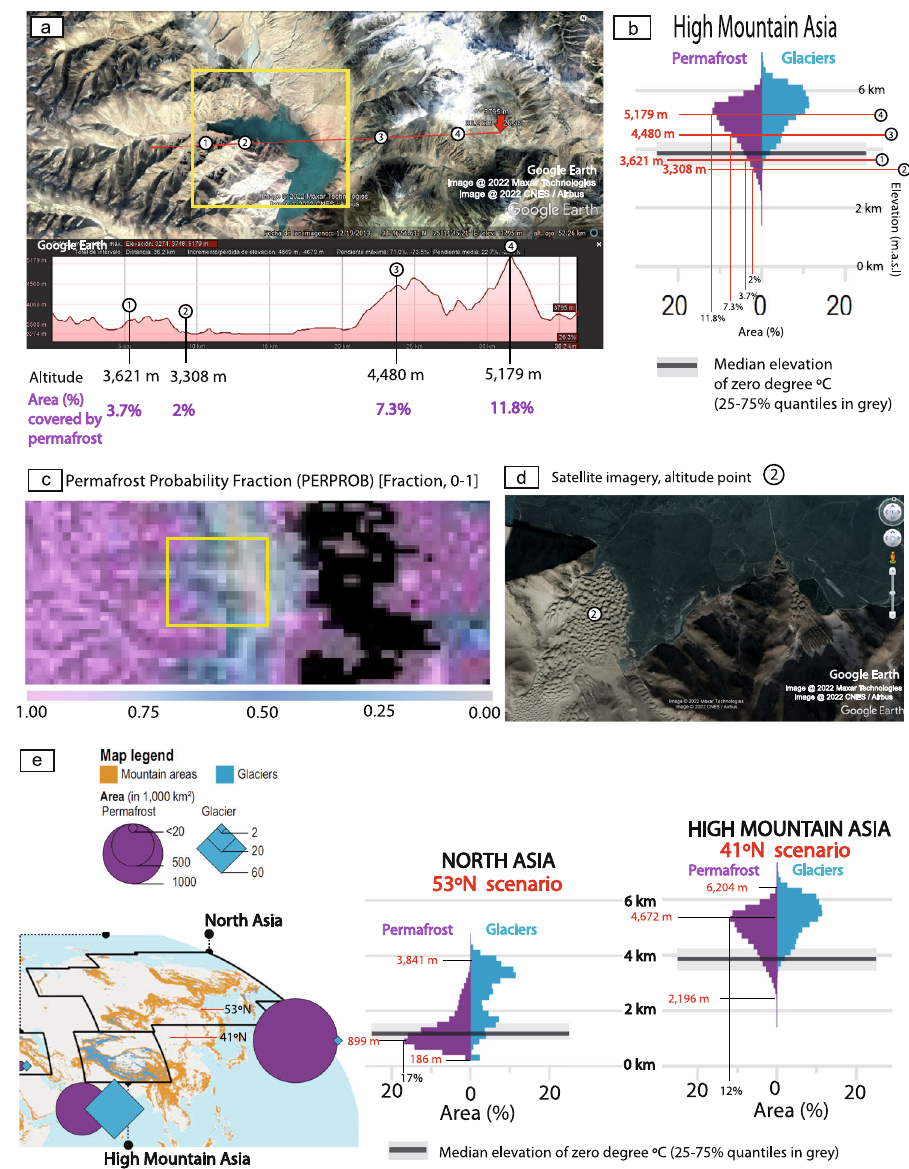
Fig. 6 | Altitudinal and geographical distribution of high-altitude Himalayan permafrost. a Satellite imagery and topographic elevation pro fi le of the cold aeolian dune fi eld, high mountain lake and surrounding mountain systems. Image